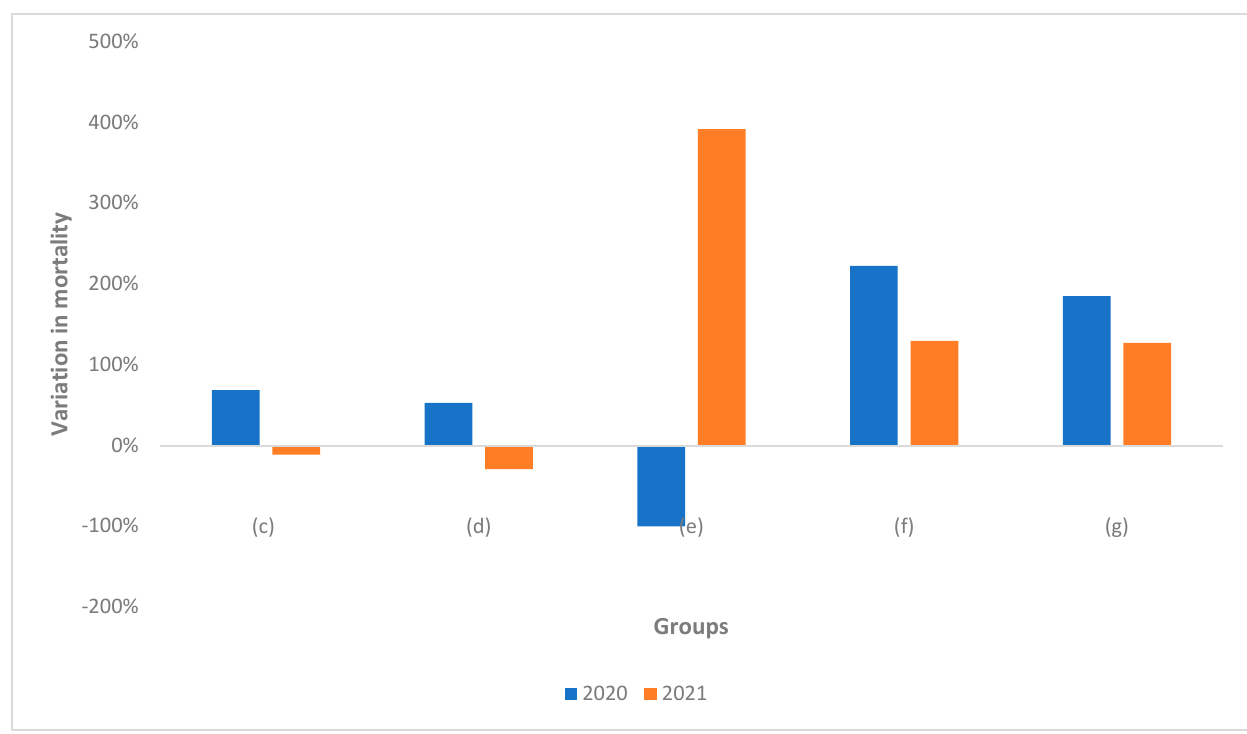
Figure 6. Variation in mortality among physicians and dentists. (c): All Doctors, (d): Physicians, (e): Dentists, (f): Physicians-Dentists, (g): All Dentists.